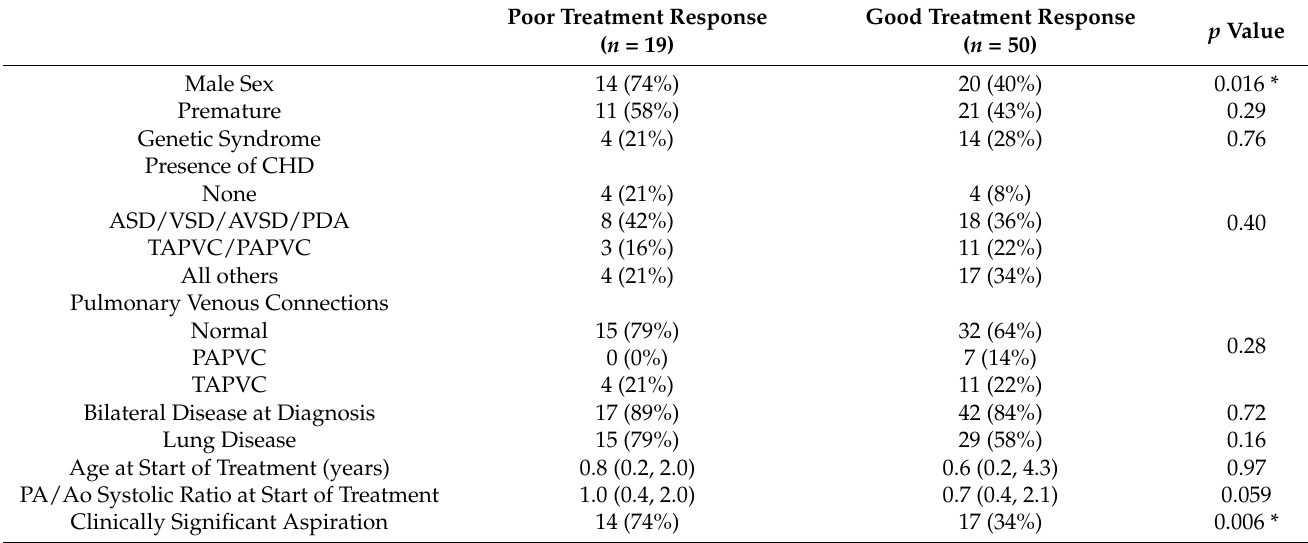
Table 1. Demographics for 2-Ventricle